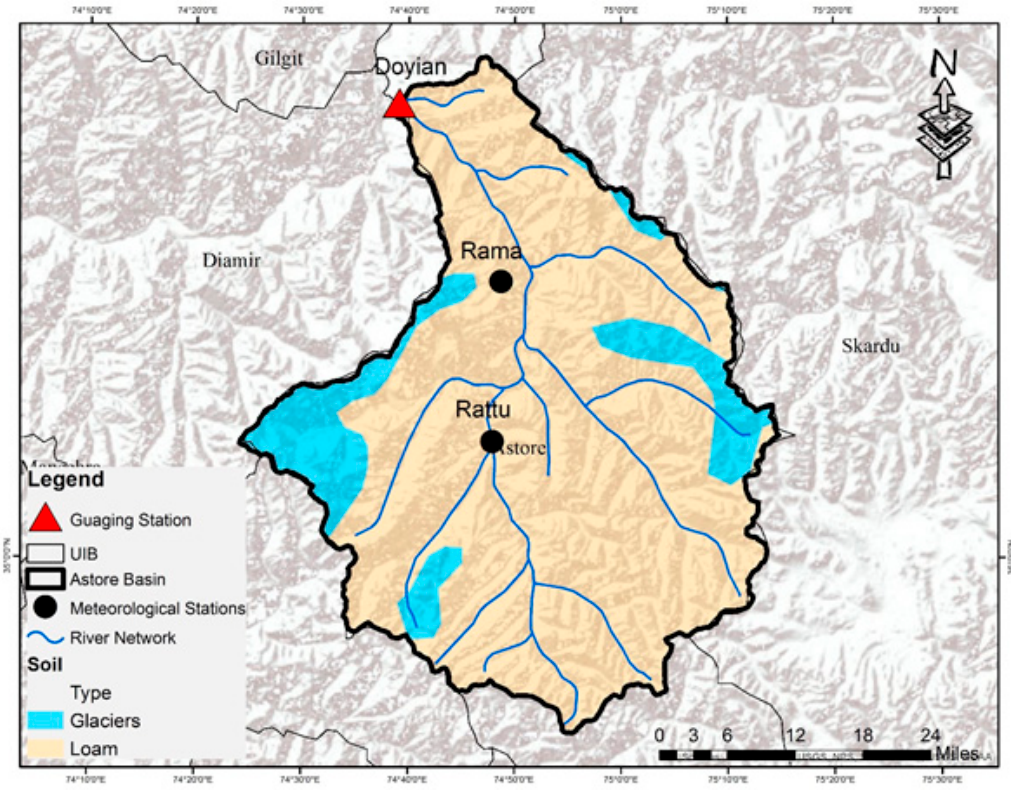
Figure 5. Classified soil map of the Astore Basin.